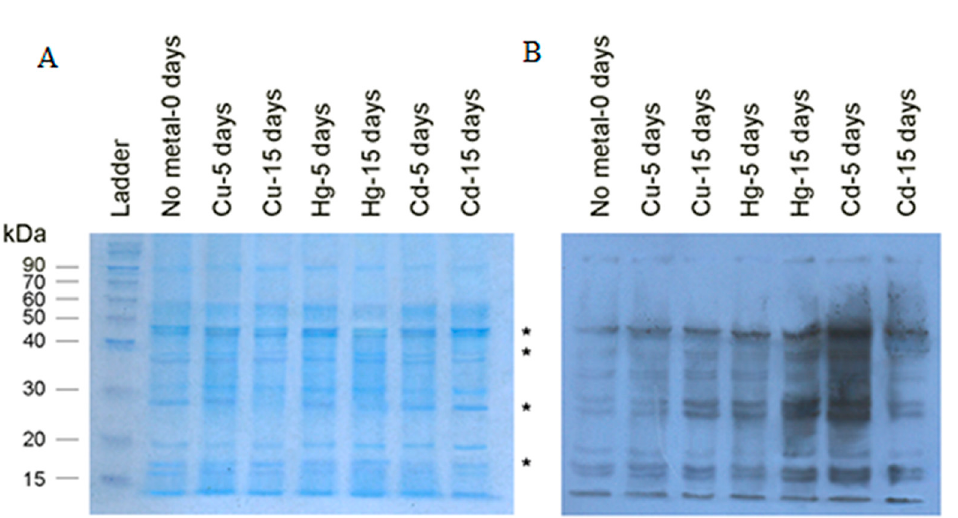
Figure 3. Profile of carbonylated proteins in the fraction of translation factors (Washed Ribosomal Factors, FWR) investigated by Coomassie staining ( A ) and Western blotting for DNP ( B ) in 12% SDS-PAGE gels isolated from non-exposed (no metal-0 days) or exposed mussels to 40 µ g / L Cu,